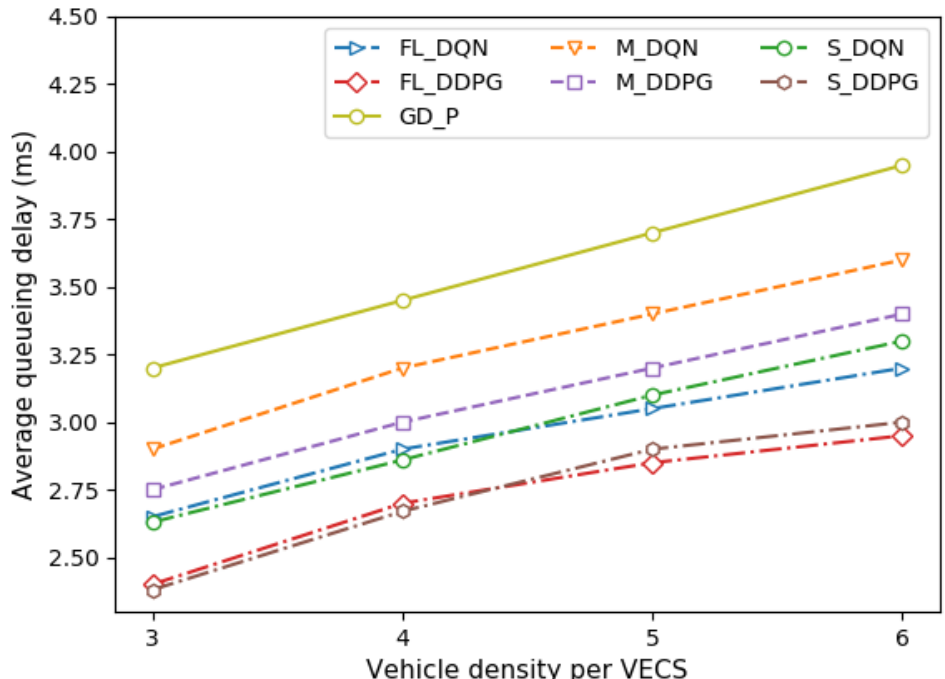
Figure 8. Comparison of queueing delay under different vehicle densities.